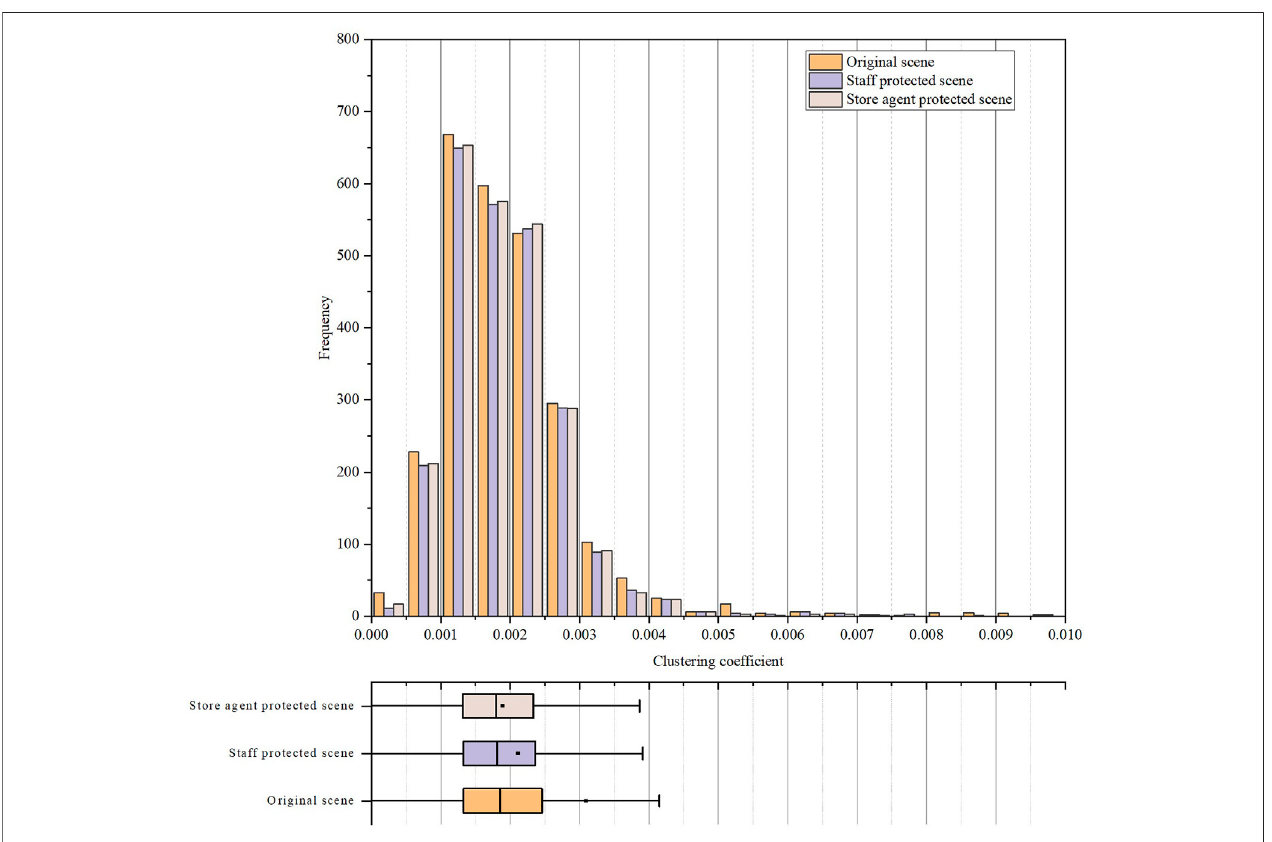
FIGURE 11 | Frequency of clustering coef fi cient in different